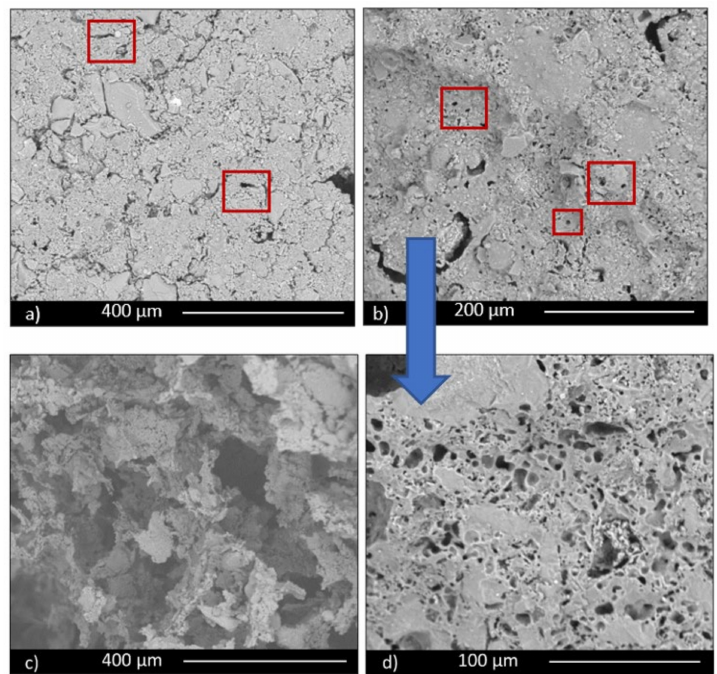
Figure 3. Micrographs of samples: ( a ) PR.FG30, obtained by pressing; ( b ) PE.FG30, obtained by pelletization; ( c ) scaffolds (SS FG30); ( d ) higher magnification image of sample ( b